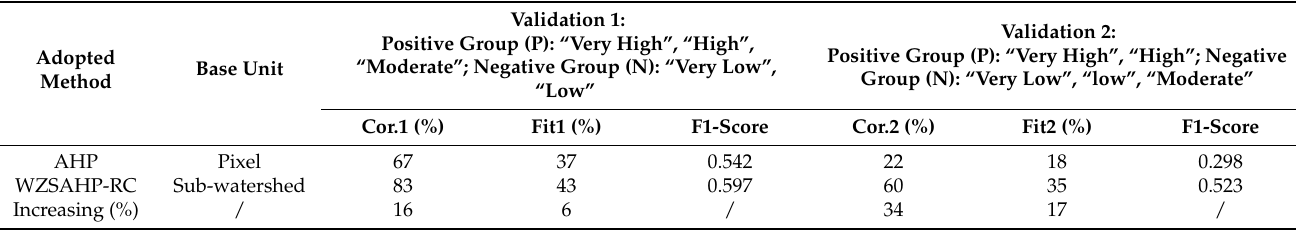
Table 7. The correct ratio, fit ratio and F1-score were calculated by the pixel-based AHP method and the proposed sub-watershed-based WZSAHP-RC method.